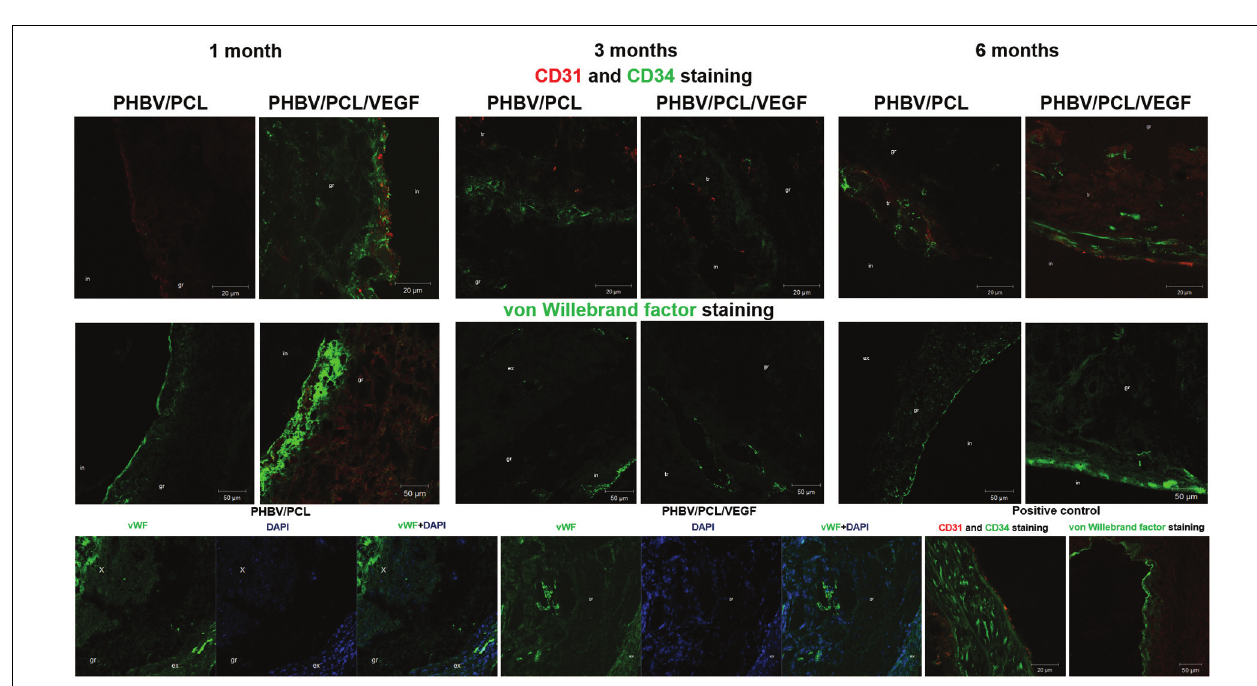
FIGURE 4 | In vivo performance of PHBV/PCL vascular grafts with and without VEGF: confocal laser scanning microscopy. PHBV/PCL grafts with VEGF contained many CD31-, CD34-, and vWF-positive cells which therefore were defined as endothelial cells but this was not the case for unmodified grafts. Furthermore, combined vWF- and DAPI staining revealed a significant increase in a total number of cells within the graft in PHBV/PCL/VEGF compared to PHBV/PCL grafts 6 months postimplantation. Native rat abdominal aorta was used as a positive control. CD31-positive cells are stained red while CD34 and vWF-positive cells are stained green. X, tr, in, gr, and ex are for neointima, thrombus, inner, middle, and upper third of the graft.